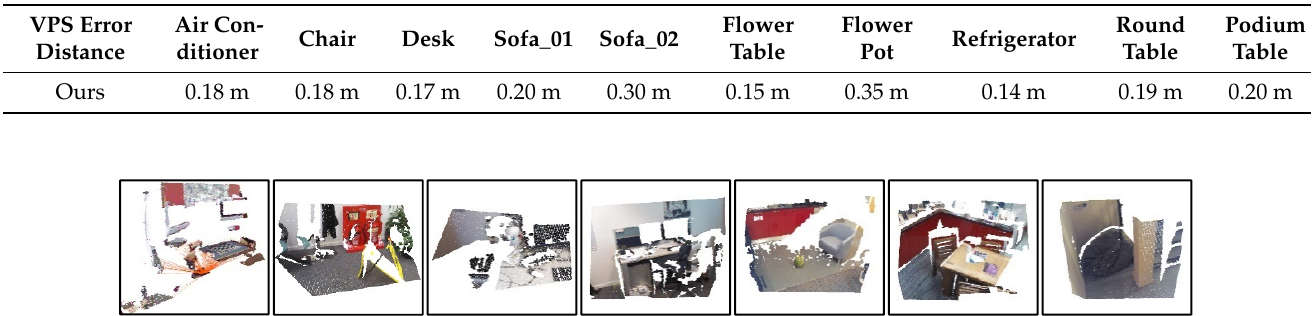
Table 5. Visual positioning system (VPS) error distance.